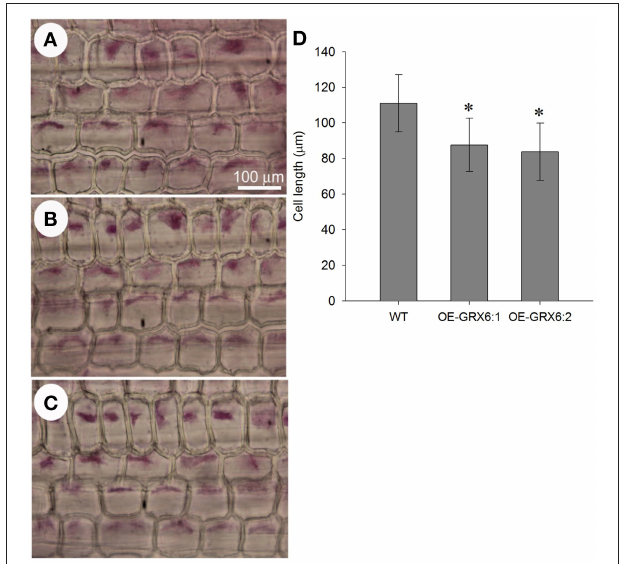
FIGURE 10 | Leaf sheath cell size in the wild type (A) and in the transgenic lines OE-GRX6-1 and OE-GRX6-2 (B,C) 4 weeks after planting, and cell length (D). Data is a mean of 15 measurement ( ± SD). Asterisks indicate significant differences at p ≤ 0.05 level.